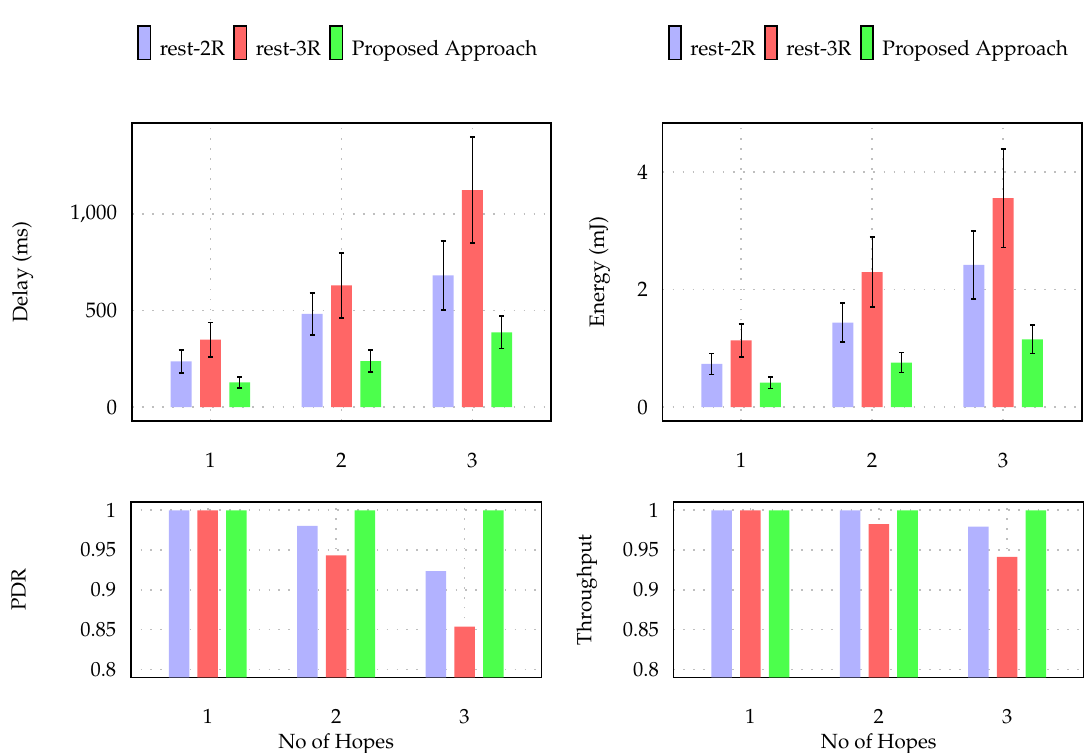
Figure 12. Scenario 3: Average delay, energy consumption, PDR, and throughput comparisons with increasing number of sender